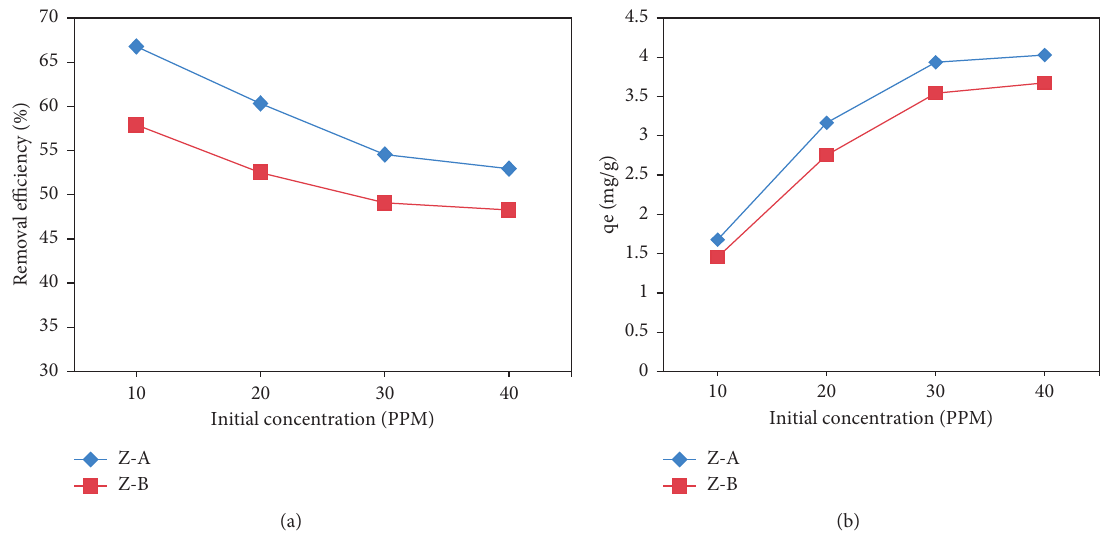
Figure 5: (a) Effect of dye concentration on removal efficiency and (b) adsorption capacity of Z-A and Z-B.